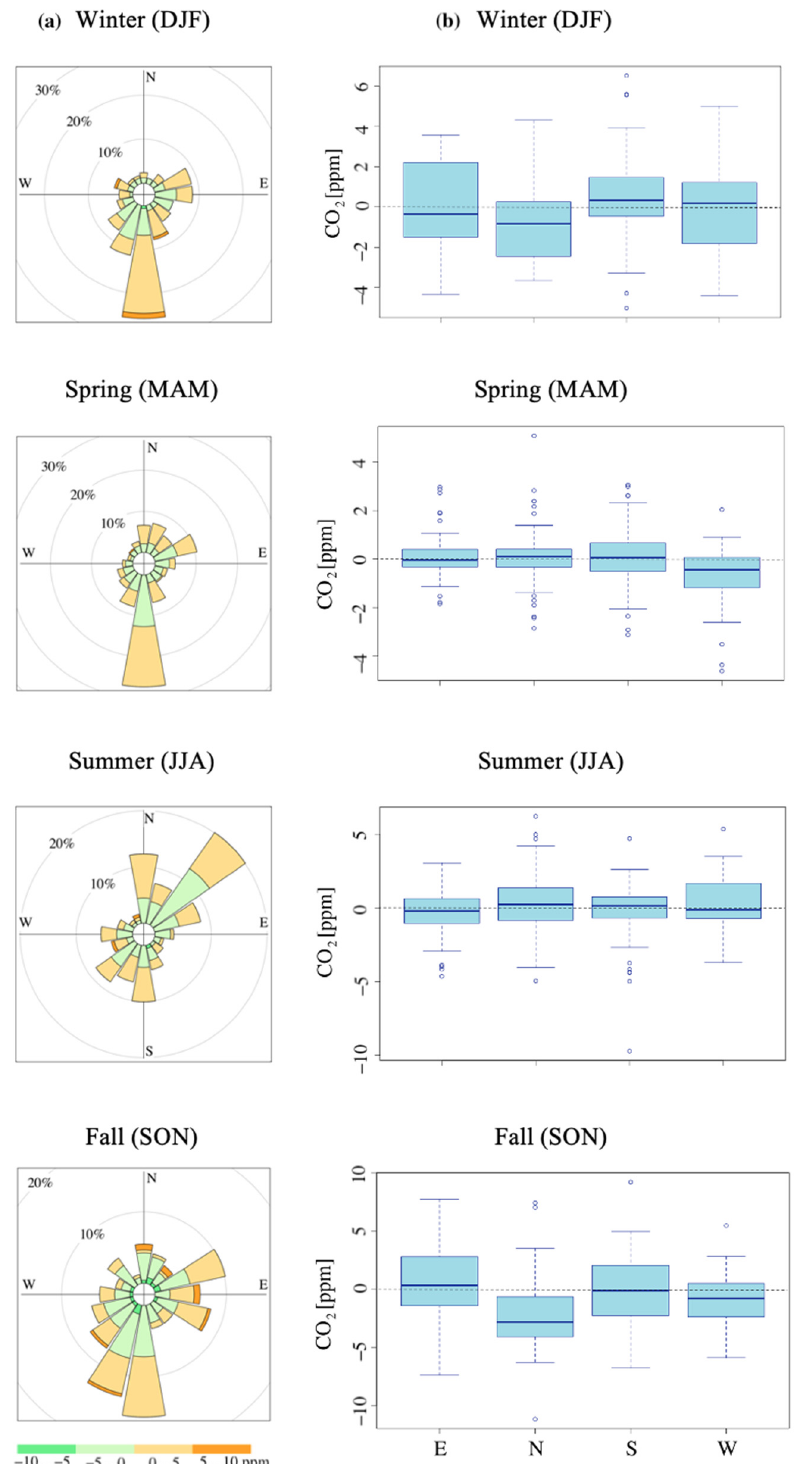
Figure 7. Angular distribution of atmospheric CO 2 anomalies for the period of observations at the measurement station “DIAMIS”: ( a ) frequency of counts (%) and dry mole fractions (ppm). Afternoon data records for CO 2 (1–4 pm LT) are presented; ( b ) distribution of atmospheric CO 2 anomalies throughout the year along with four geographical domains, where negative values ( − indicate an uptake of CO 2 , and positive values (+) indicate a release of CO 2 . For each box, the central line indicates the median, the bars represent the lower ‘hinge’ and the upper ‘hinge’ and the extremes of the upper and lower whiskers. Dots indicate